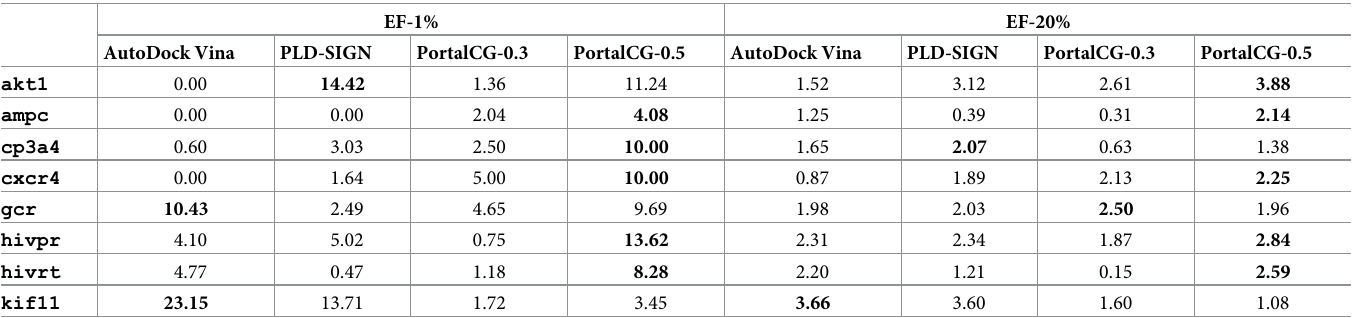
Table 3. Compound screening performances evaluated using the DUD-E benchmark. For “PortalCG-0.3”, the similarities between chemicals in the training/validation set and those in the testing set are less than 0.3 of the Tanimoto Coefficient (TC). For ‘PortalCG-0.5’, the similarities between chemicals in the training/validation set and those in the testing set are less than 0.5 of the TC. The best performance is accentuated in bold